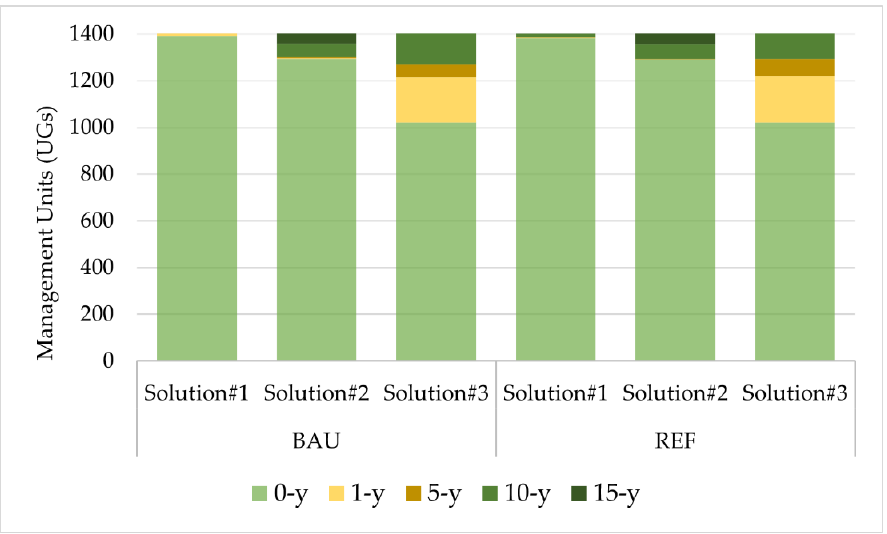
Figure 4. Fuel treatment prescriptions (no fuel treatment: 0-y; annually: 1-y; each 5-years; 10-years; and each 15-years) optimal distribution across the landscape, for each optimal solution and local-climate scenarios.